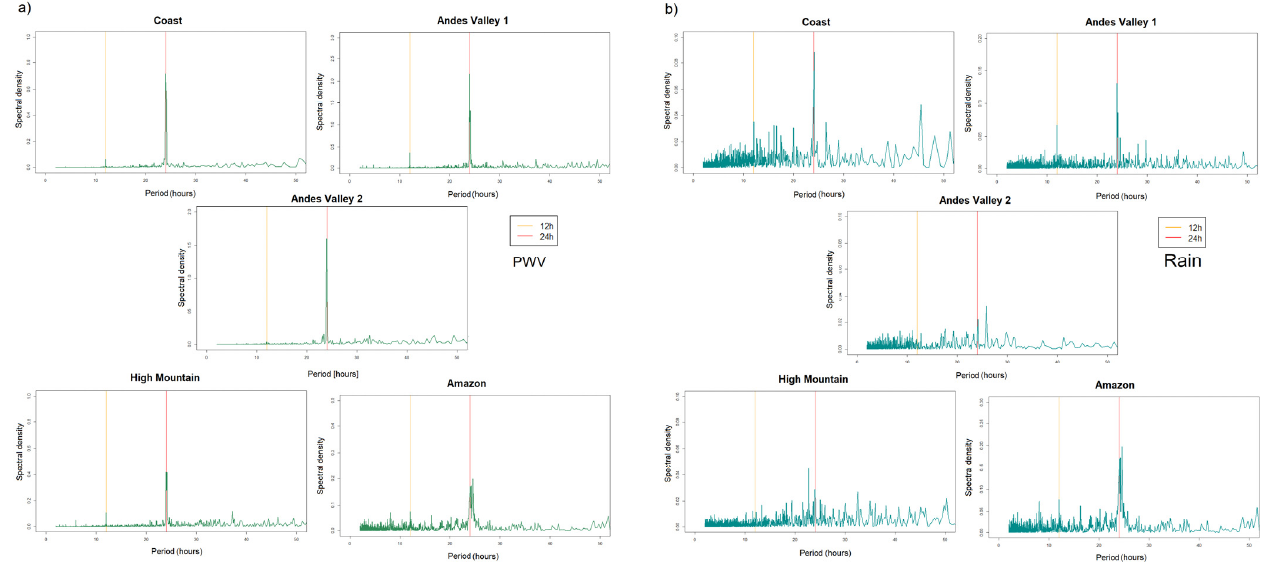
Figure A1. Characteristic periods of ( a ) PWV. Note the marked period of 24 h and the secondary one of 12. In the Amazon region, the spectral density is lower and there are two more characteristic periods of 8 and 16 h ( b ) rain. Note the lower spectral density in comparison with PWV, and the characteristic period of around 24 h.